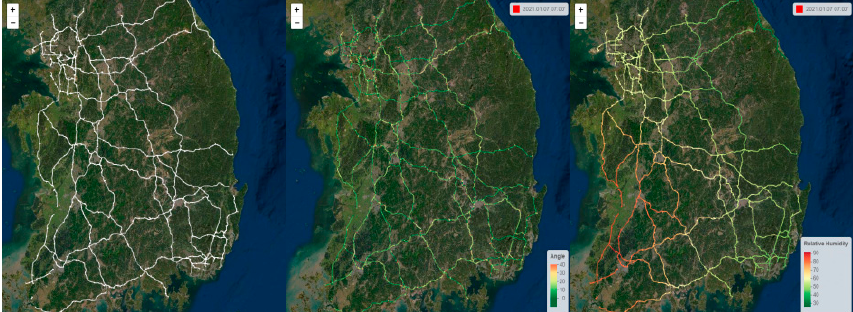
Figure 3. Location of Korean highways, angle of rotation by link, humidity by link.